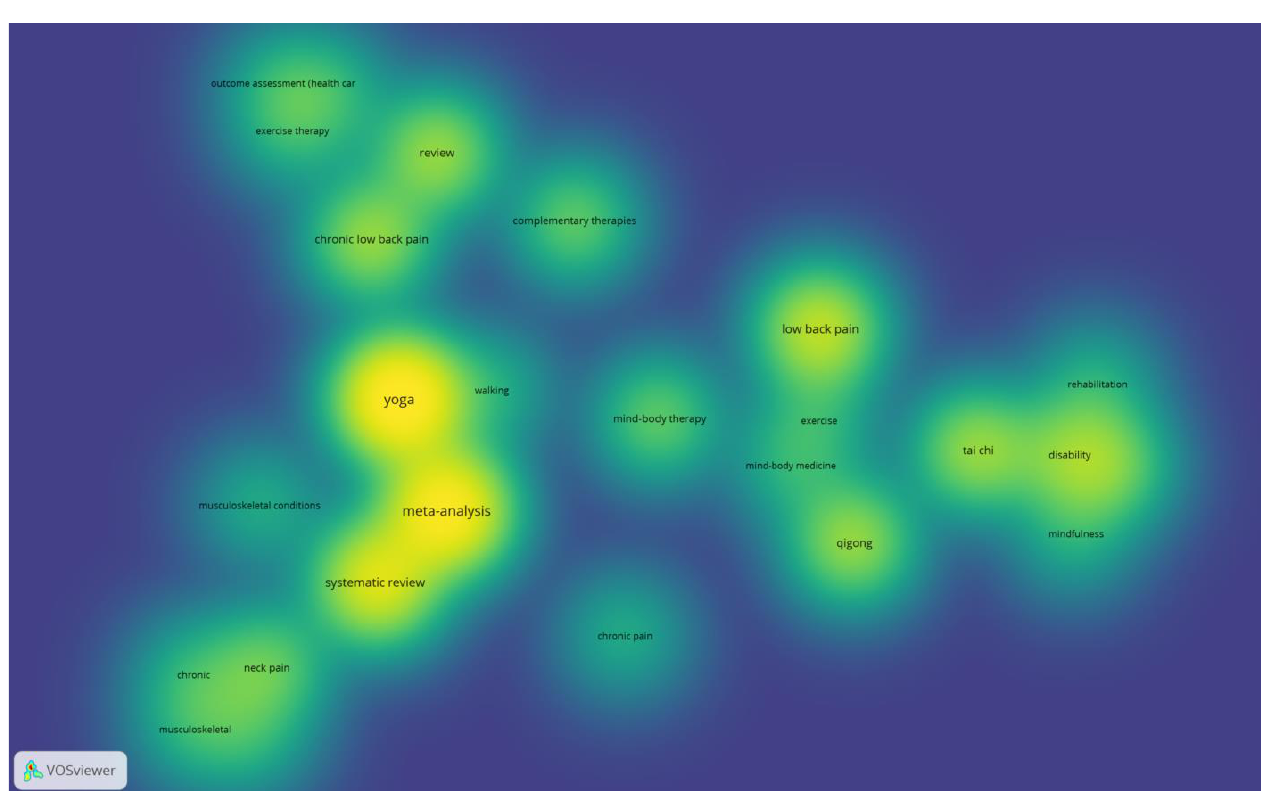
Figure 2. Network Visualization .